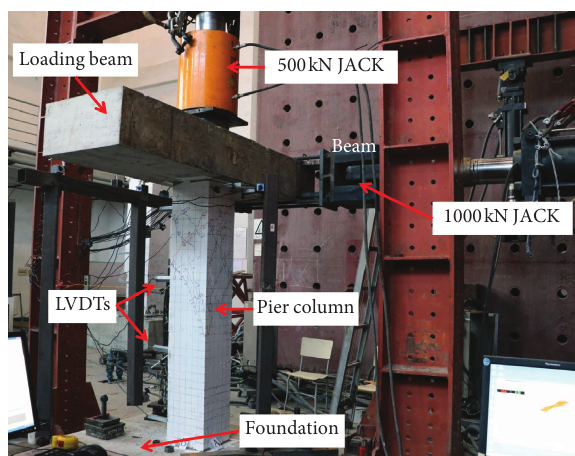
Figure 3: Photograph of the test model installed on the facility.